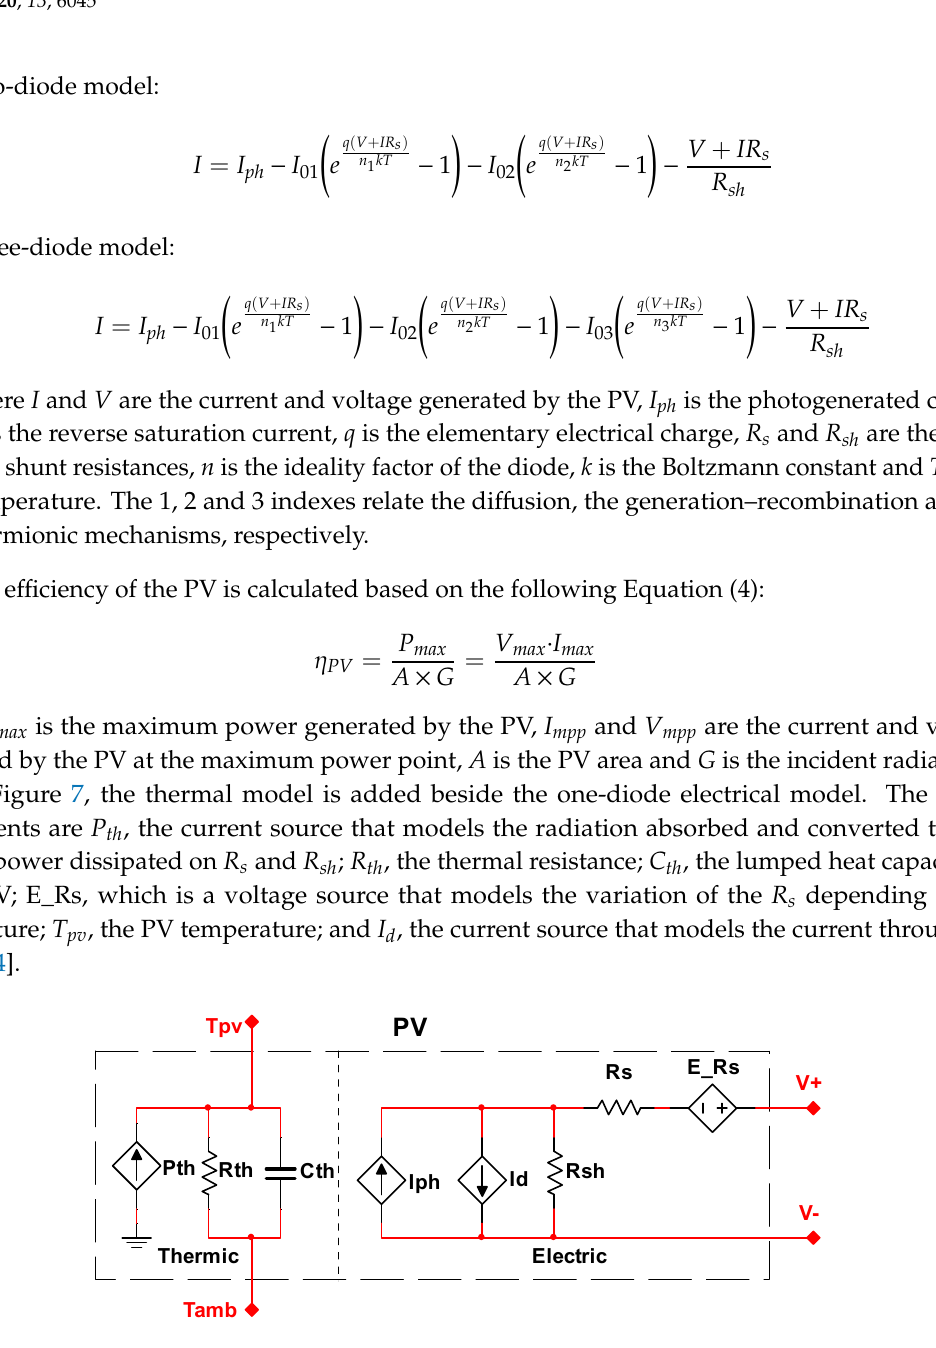
Figure 7. PV model—electrical and thermal parts